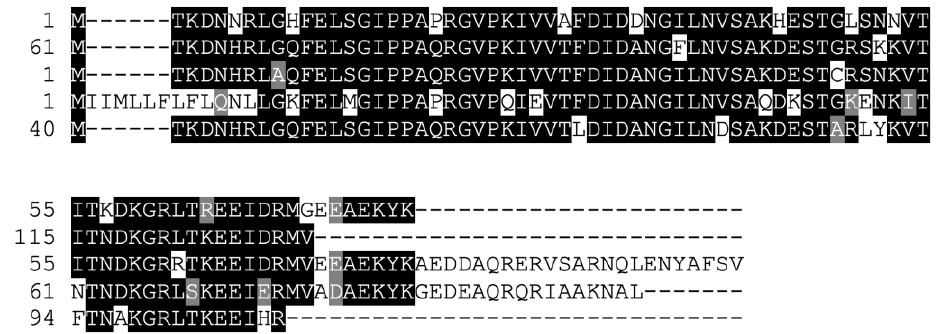
Figure 4. Alignment of the conserved domains of the Hsp70 homologs identified in the RNC tran- Figure 4. Alignmentoftheconserveddomainsofthe Hsp70 scriptome.